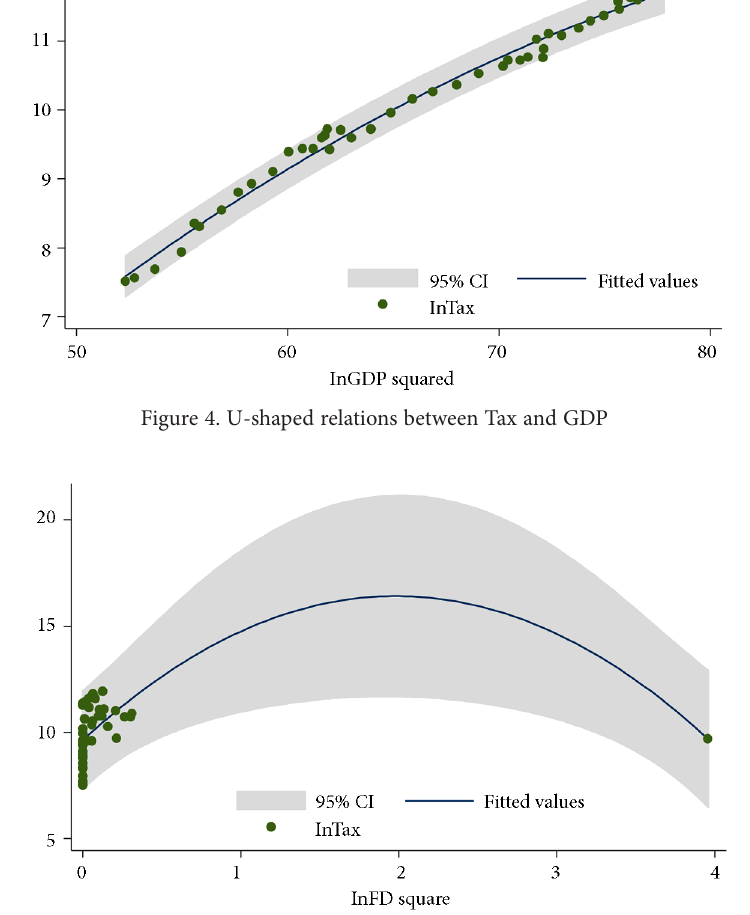
Figure 5. Inverted U-shaped relations between Tax and